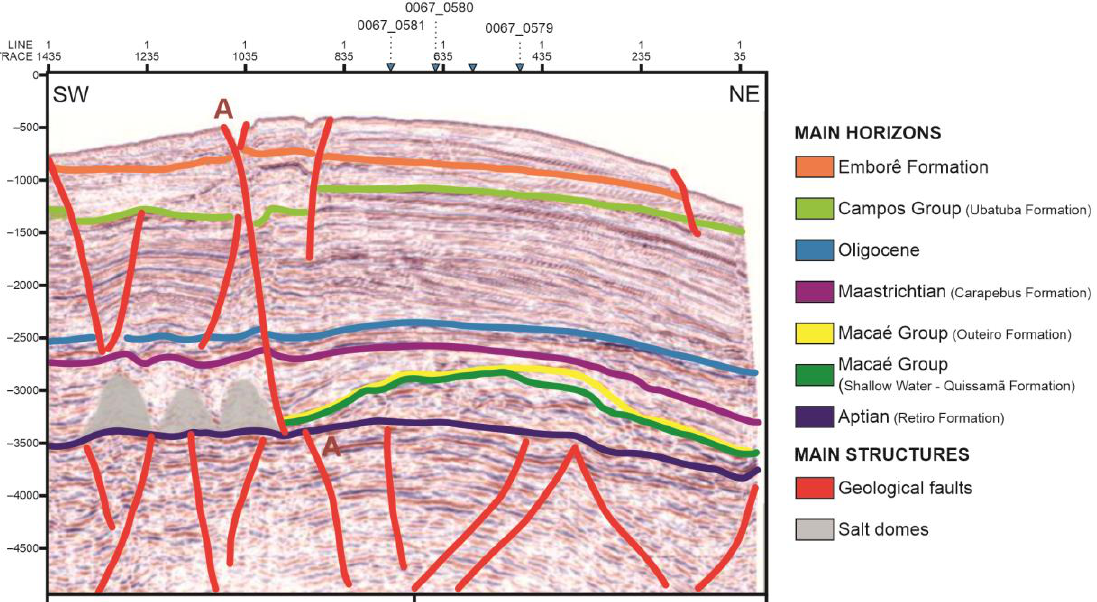
Figure 10. Interpretation of the 2D seismic reflection line 53-420, near the ring fence area of the Roncador Field, in the Campos Basin, Brazil, adapted from Furlan and Vincentelli [22]. The Carapebus Formation reflector corresponds to the top of the Upper Cretaceous